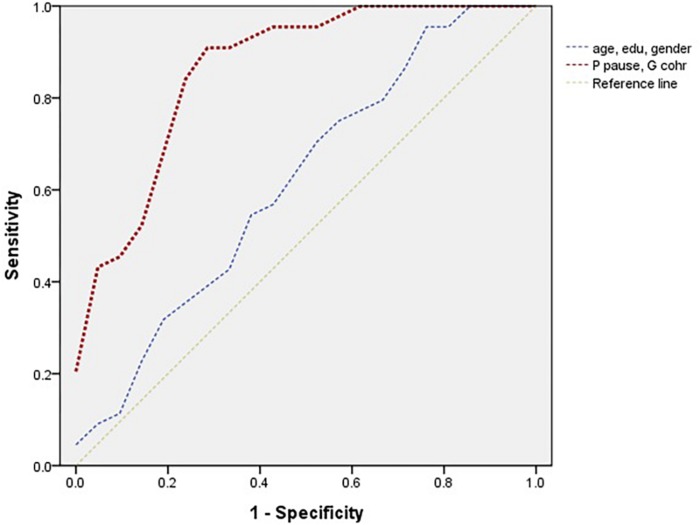
Receiver operating characteristic curve in two influential measures (i.e., the proportion of pauses and global coherence) and controlling variables in naMCI and HC.